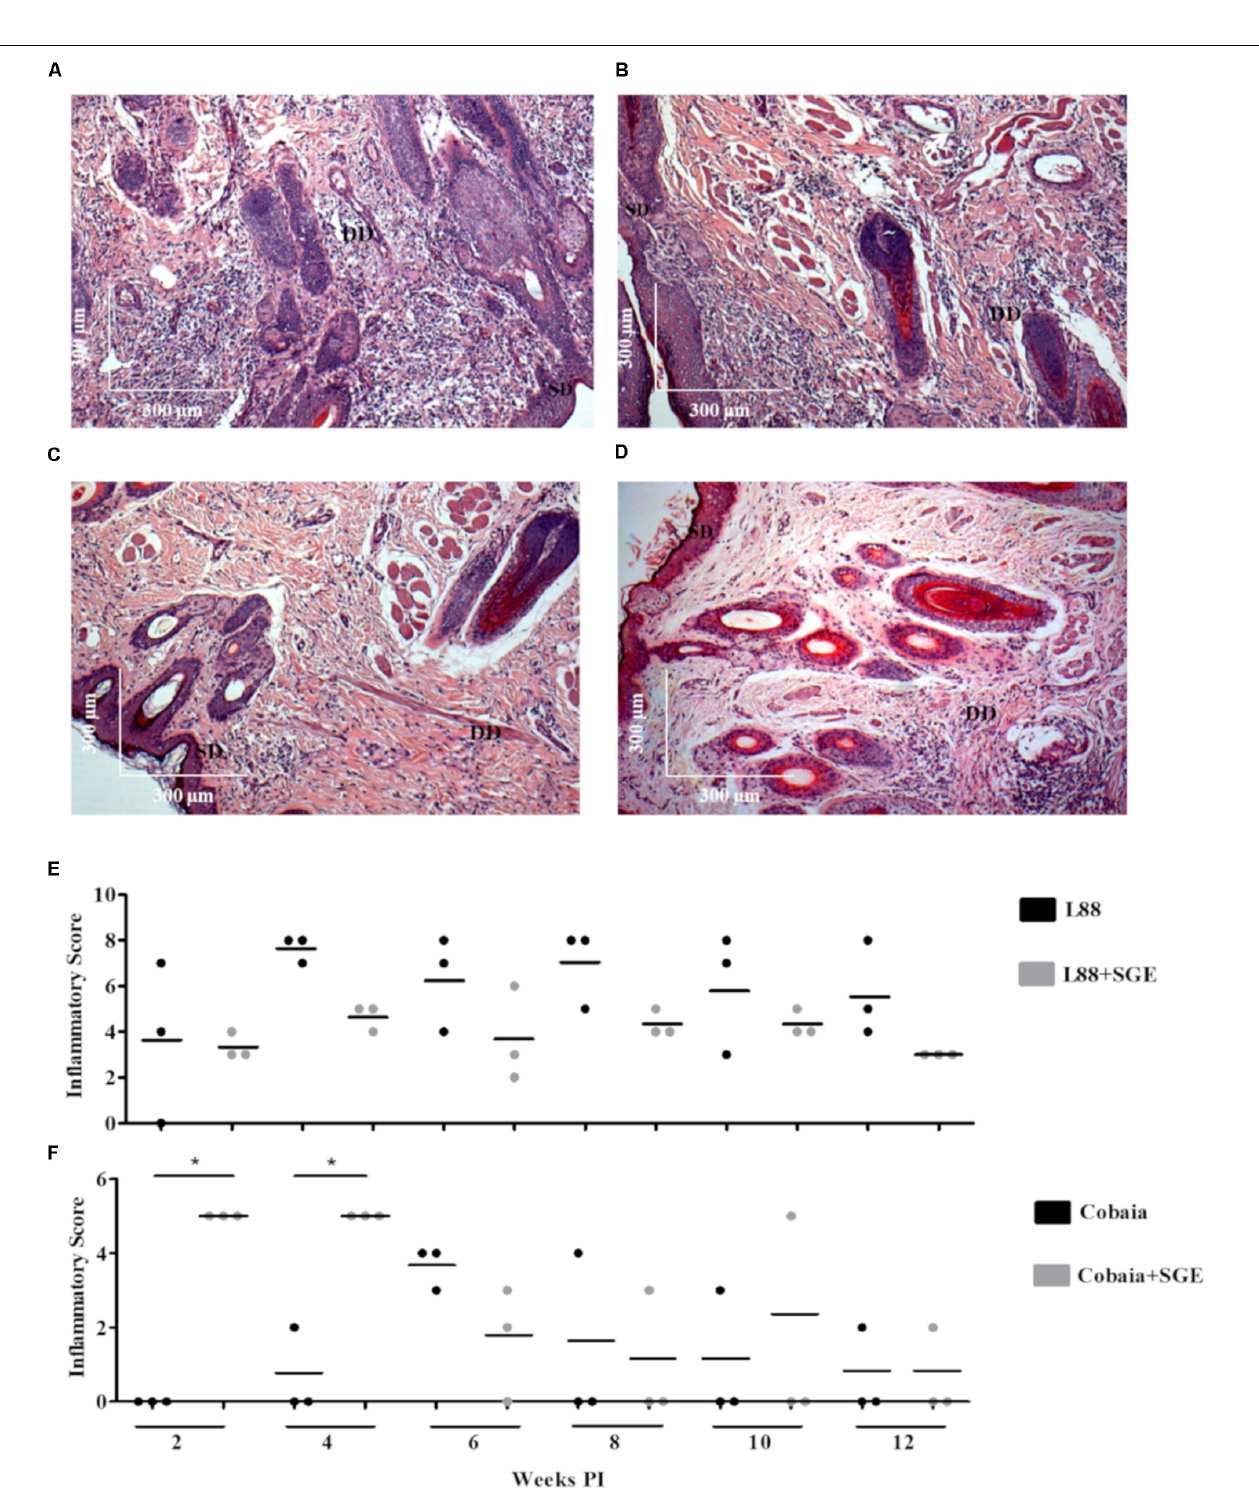
FIGURE 3 | Histopathology (HE) of C. porcellus infected with L. enriettii (L88 and Cobaia) strains in the absence/presence of salivary gland extract (SGE). L88-infected animals exhibited an intense and diffuse chronic inflammatory process at 6 weeks PI in the absence (A) and presence (B) of SGE. In the absence of SGE Cobaia-infected animals exhibited a lower chronic inflammatory reaction (C) than in the presence of SGE (D) at 4 weeks PI. Inflammatory Scores of C. porcellus infected with L. enriettii strains L88 (E) and Cobaia (F) in the absence/presence of SGE at 2, 4, 6, 8, 10 and 12 weeks PI. DD deep dermis, SD superficial dermis. Asterisks indicate statistical significance between groups at p <